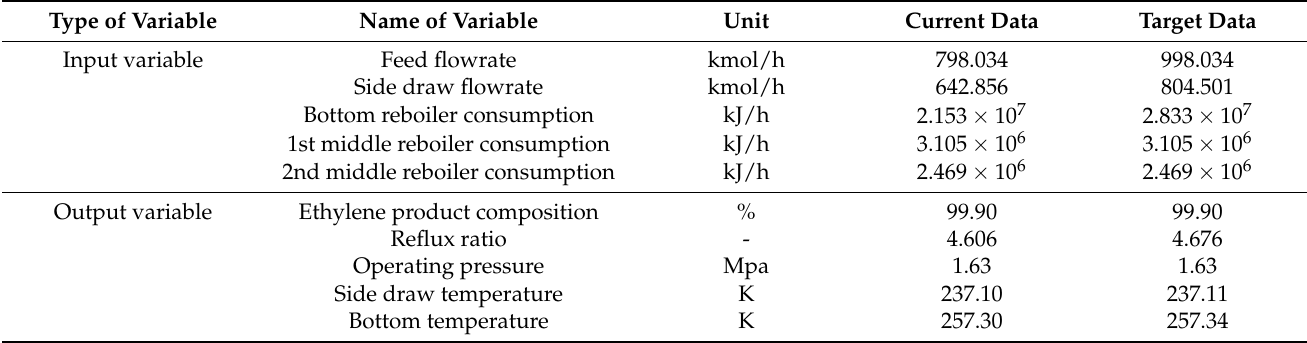
Table 2. Data in diverse working points.